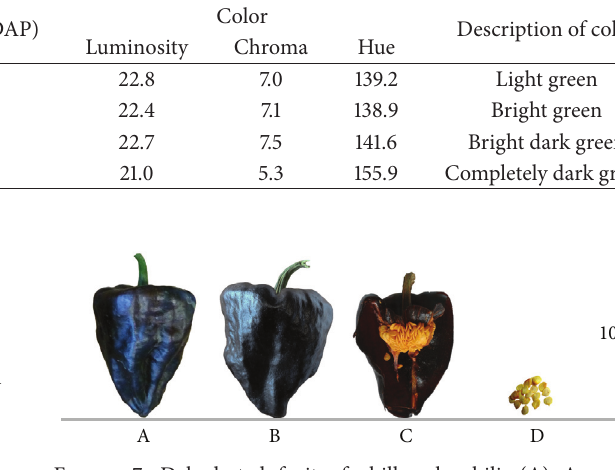
Figure 7: Dehydrated fruit of chilhuacle chili. (A) A mature fruit, showing the apex, which consists of a thick pericarp and placental tissue to which the seeds are attached. (D) In mature dehydrated fruits, the seeds are flattened and yellow in